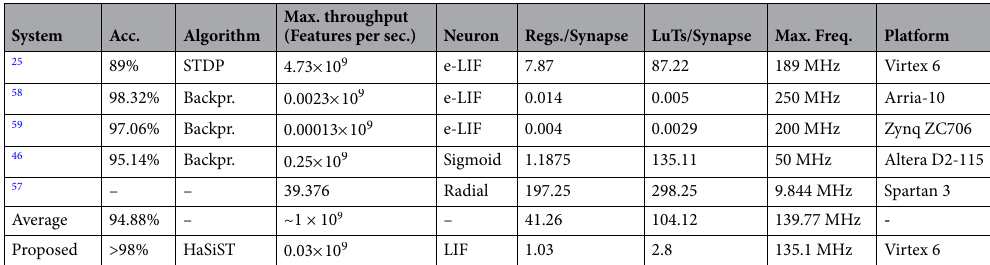
Table 3. Cost and throughput comparisons: inference engines.